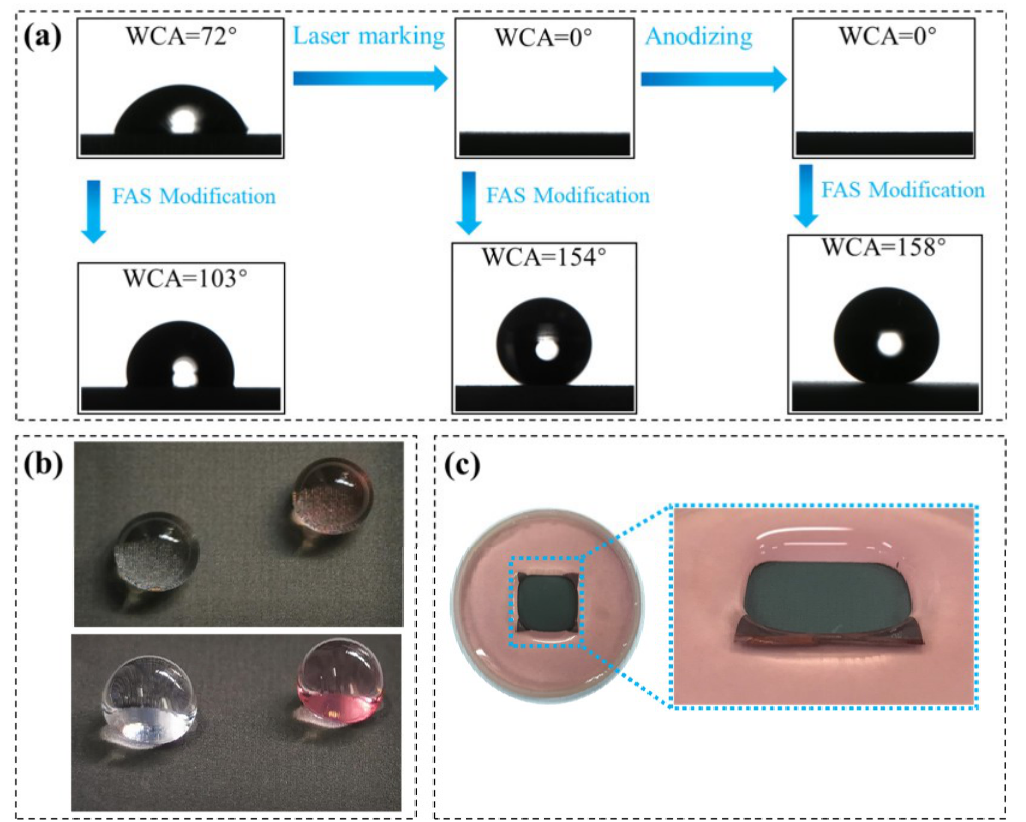
Figure 5. Wetting behavior of the prepared samples: ( a ) surface wettability of samples at different stages, ( b ) the water droplets on the modified surface after laser marking and anodizing and ( c ) the sample immersed in water after laser marking and anodizing, showing a water-free surface below the water